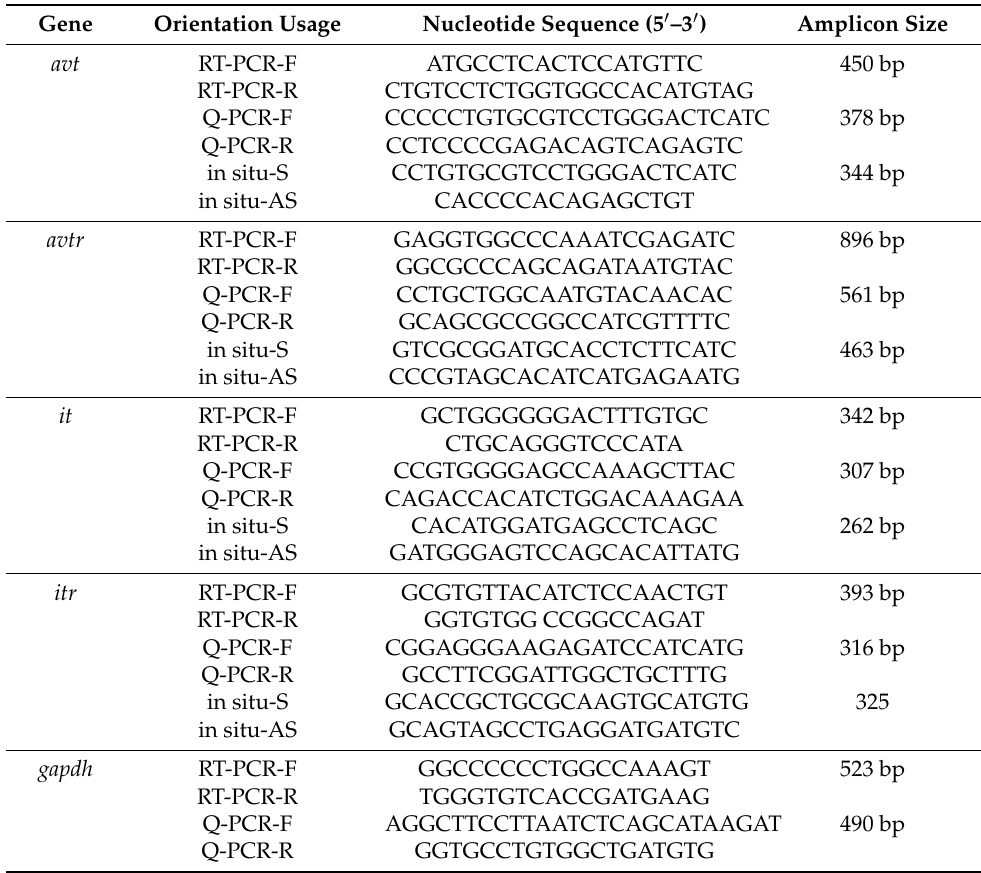
Table 1. Oligonucleotide primers used for specific primers for reverse transcription PCR (RT-PCR), quantitative real-time PCR (Q-PCR) analysis, and in situ hybridization. S: sense primer, AS: anti-sense primer, F: forward primer, and R: reverse